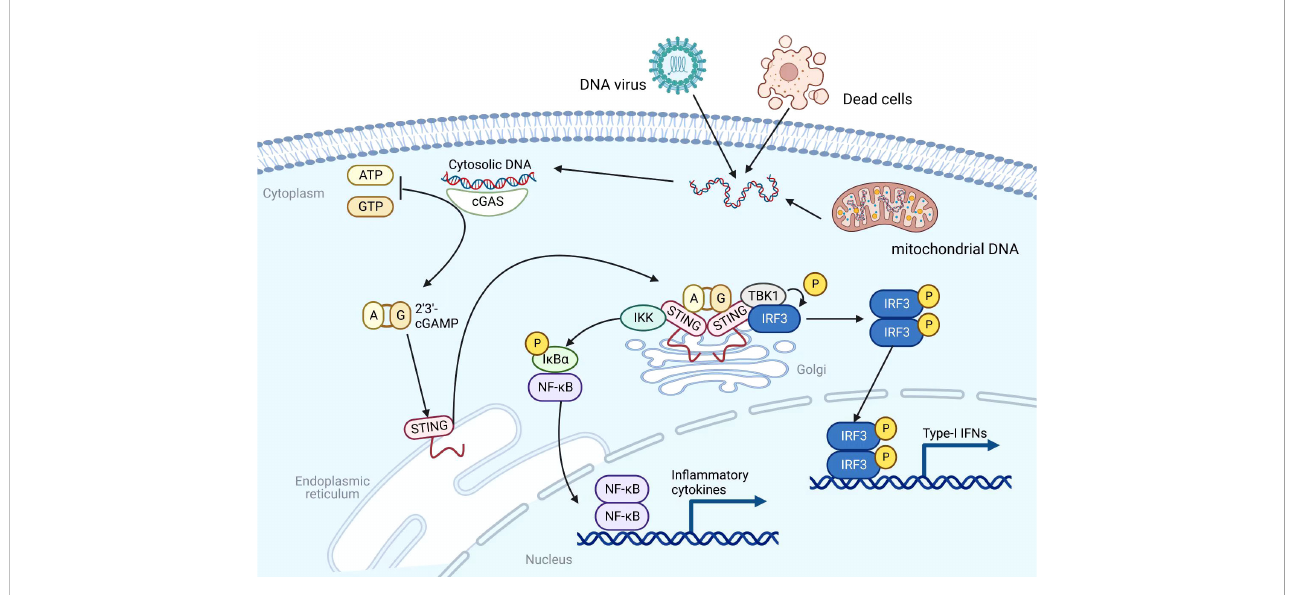
FIGURE 1 Mechanism of the cGAS-STING pathway. Created with